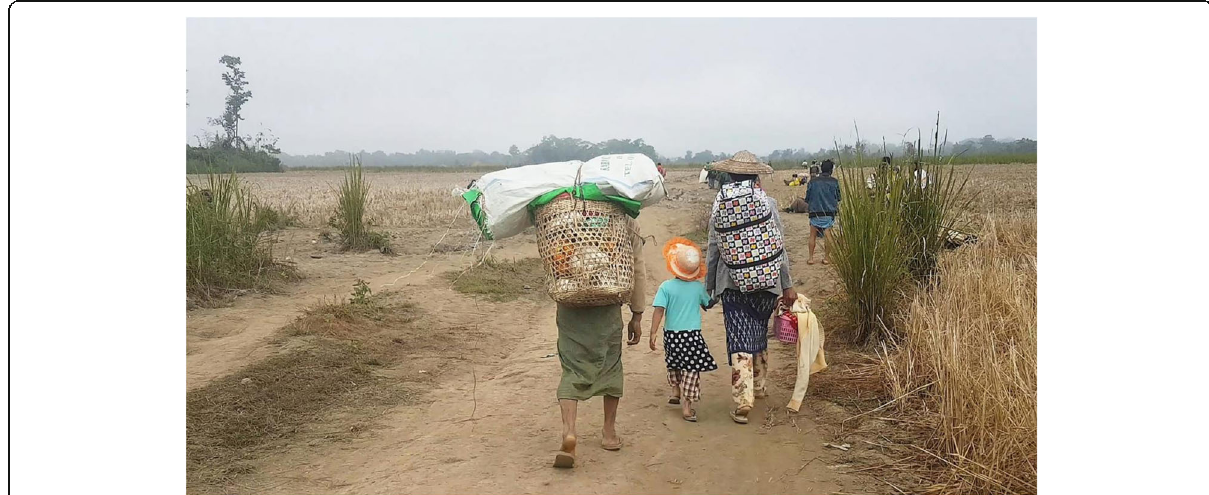
Fig. 3 A Burmese family from an internally displaced person (IDP) camp head to an amber mine at Mine Khun, near Tanai, in December 2017. They carry the minimal provisions, including a green tent and the illusion of an income from amber